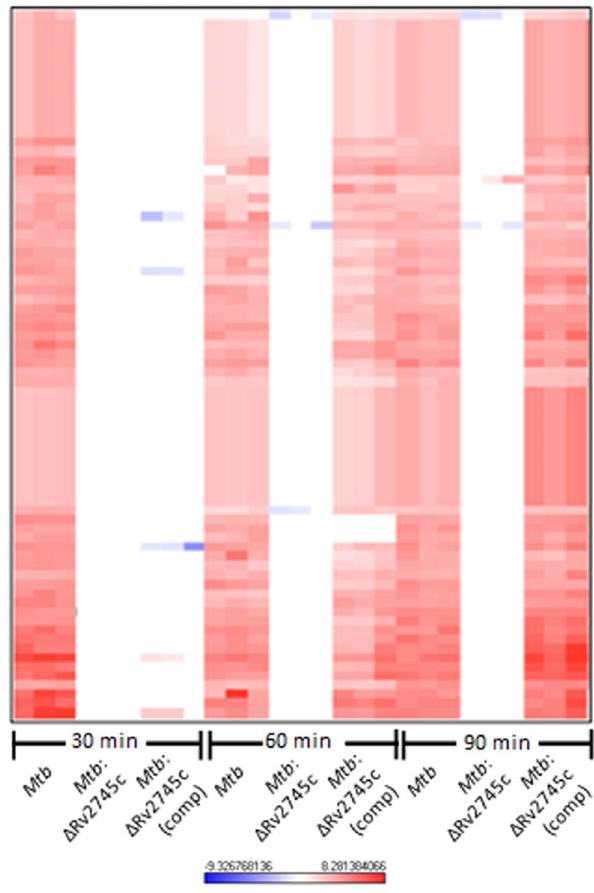
Figure 3. Diamide Induced Genes. The heat map show results of unsupervised hierarchical clustering focusing on the genes with the highest magnitude of change. A majority of genes induced by diamide treatment in Mtb are also induced in Mtb : D Rv2745c (comp) by 60 minutes and not induced in Mtb : D Rv2745c. Genes that are induced in Mtb are also induced in Mtb : D Rv2745c (comp), whereas there is no change in expression levels in the isogenic mutant indicating that Rv2745c plays a the redox response. n=3. Red color indicates induction while blue color indicates repression, relative to the control channel. The intensity of each color corresponds to the